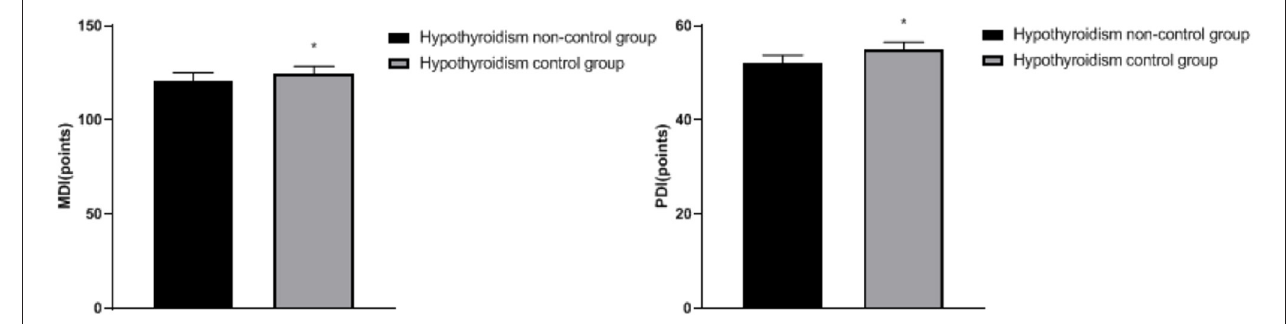
FIGURE 3 | Comparison of fetal growth and development between the two groups: compared with the hypothyroidism non-control group, * p <